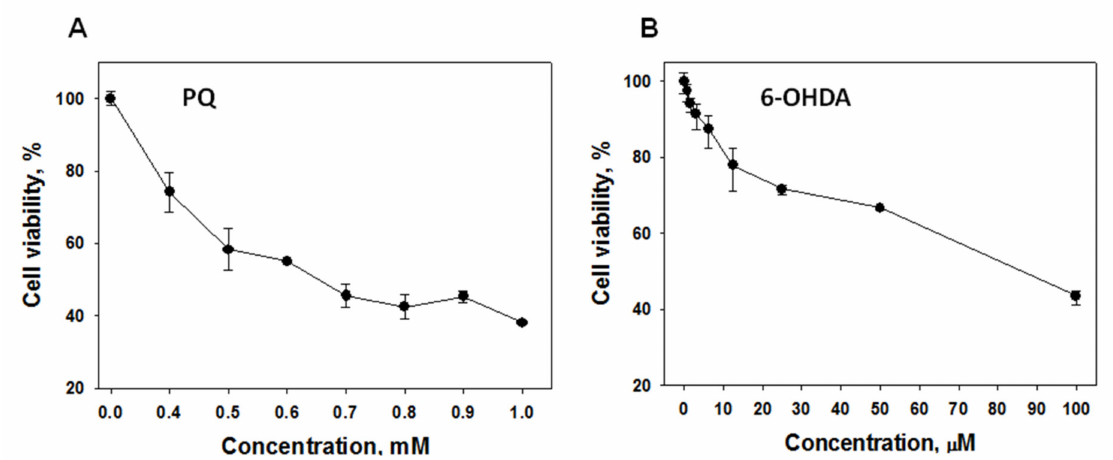
Figure A1. Cytotoxic effect of neurotoxins, PQ ( A ) and 6-OHDA ( B ), on Neuro-2a cell viability. Neuro-2a cells (1 × 10 4 cells/well) were incubated in a CO 2 incubator for 24 h at 37 ◦ C for adhesion. After that, 20 µ L of neurotoxin test solution at different concentrations was loaded to the cells and incubated for 24 h. Then, cell viability was determined by using MTT assay. Data are presented as m ± se ( n =